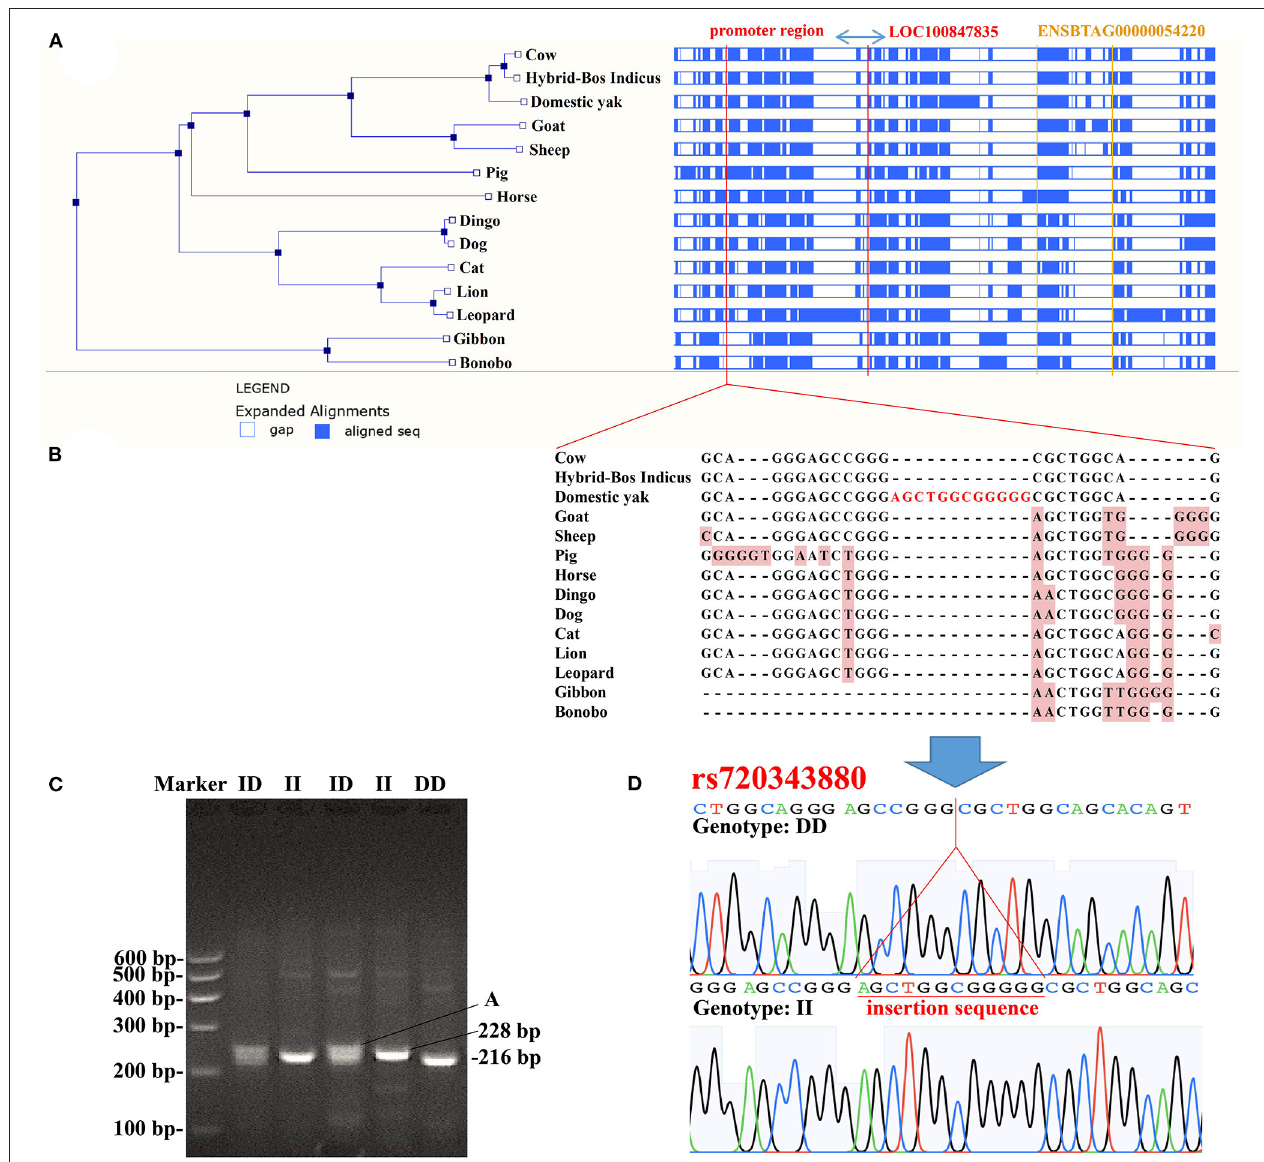
FIGURE 11 | Analysis of the 12 bp indel (rs720343880) within bovine LOC100847835 promoter region (A) , sequences alignment of LOC100847835 and its promoter region (ENSBTAG00000054220 is a lncRNA gene noted in Ensembl database); (B) , Alignment of sequences containing insertion mutation (rs720343880); (C) , Agarose gel electrophoresis patterns of rs720343880; (D) , Sequencing maps of rs720343880.